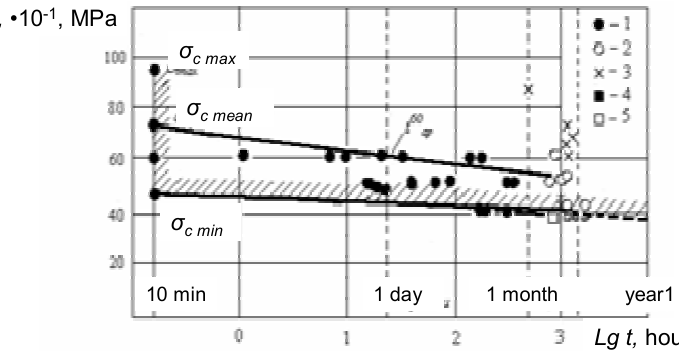
Figure 5. Durability curves for glass bars under contact axial